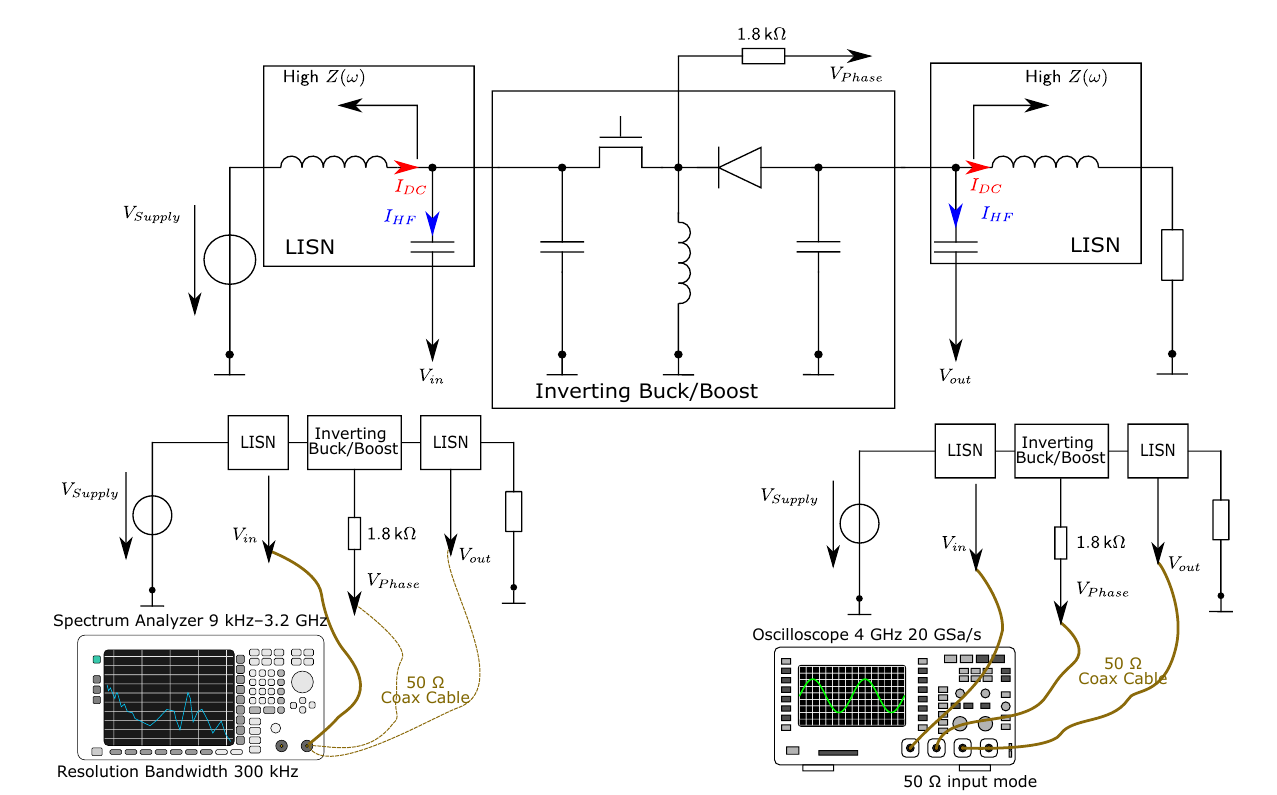
Figure 8. Measurement